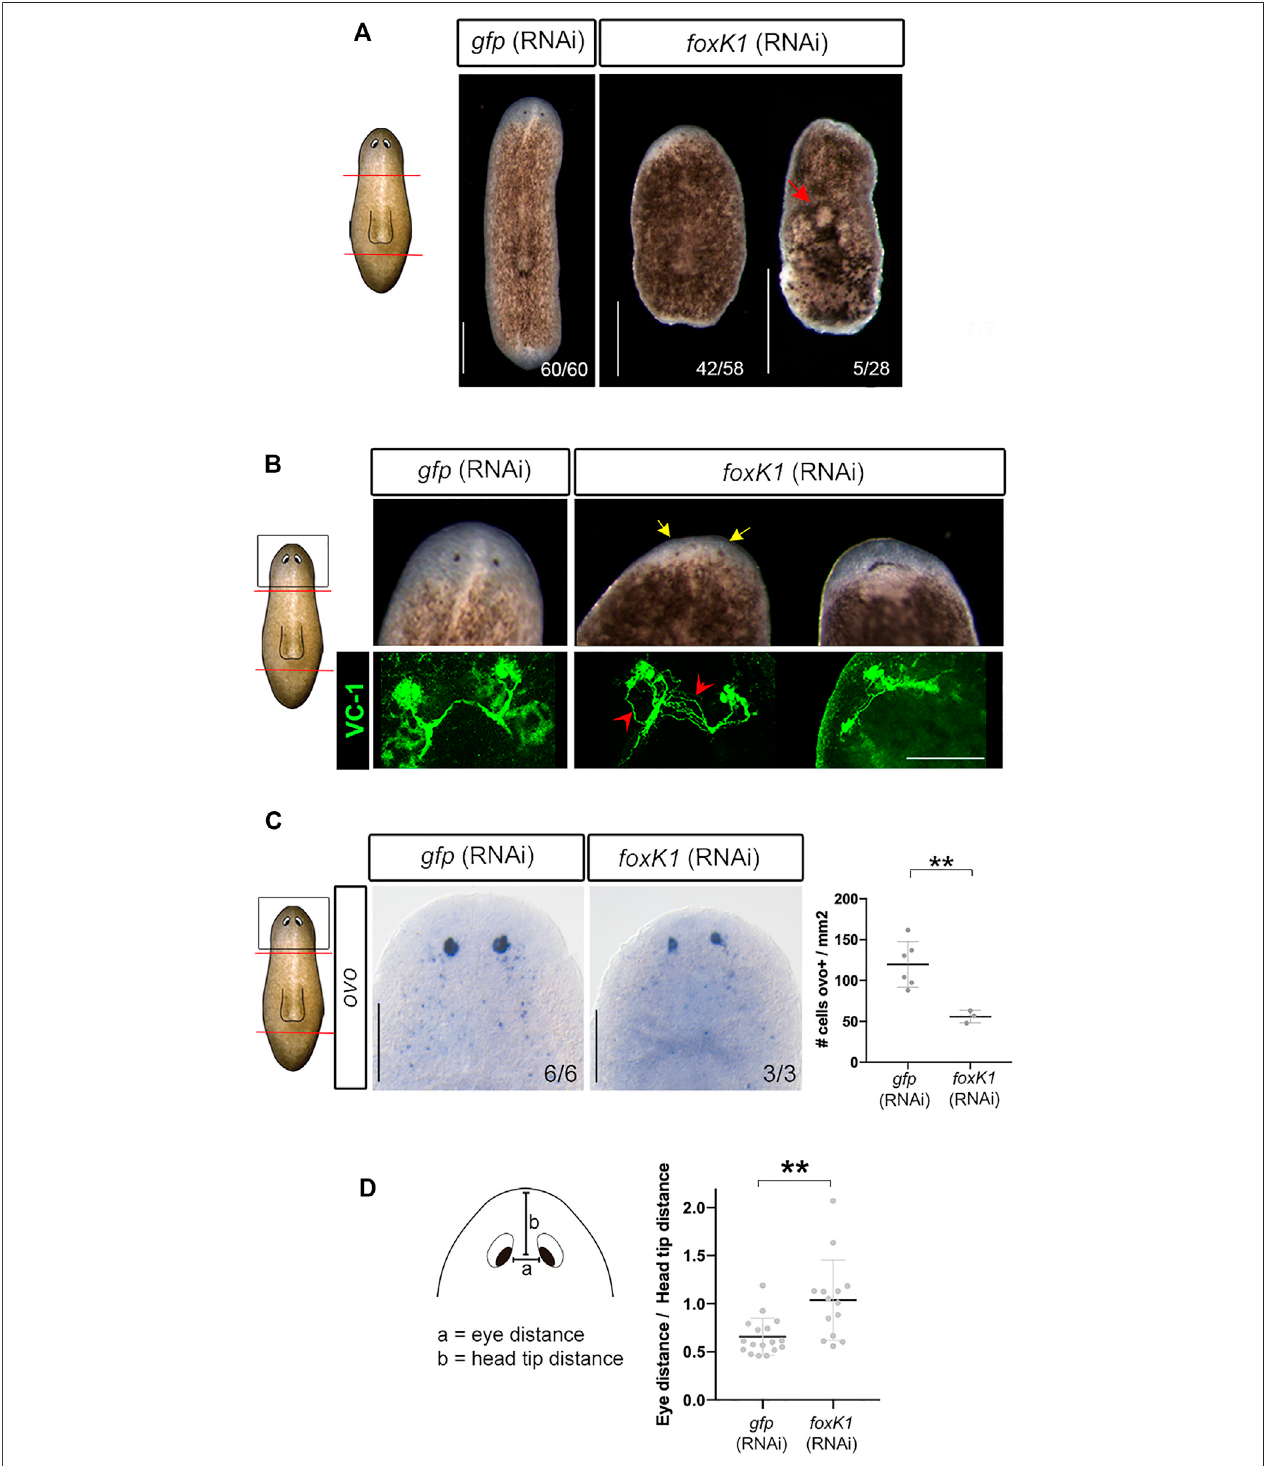
FIGURE 1 | foxK1 silencing impairs planarian regeneration and eye differentiation. (A) foxK1 RNAi animals present smaller anterior and posterior blastemas in comparison to controls. Red arrowhead points to the epidermal injuries observed in foxK1 RNAi animals. Scale bar: 500 µm. (B – D) Aberrant eye regeneration after silencing foxK1 . (B) foxK1 RNAi animals present smaller eyes that differentiate closer to the pre-existing tissue in comparison to controls (yellow arrows). Visualization of theeyeswithananti-VC1immunostainingrevealsdefectsineyeregenerationandanincorrectguidanceofvisualaxons(redarrows).Scalebar:100 µm. (C) Whole- mount insitu hybridization analysisoftheexpression of ovo in foxK1 RNAianimals.Scalebar:200 µm.Quanti fi cation of ovo +cells/mm2 showsasigni fi cantdecrease in